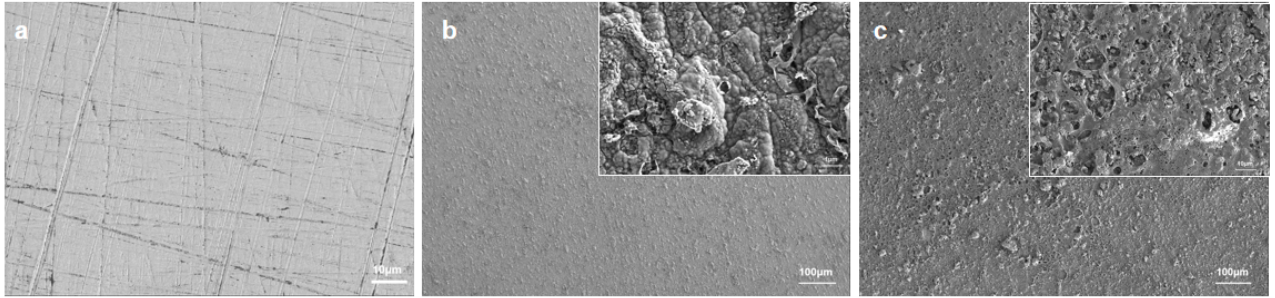
Figure 5. SEM images of di ff erent interfaces: ( a ) 316SS, ( b ) pPy/C, and ( c ) CNNS/PMMA/pPy/C.